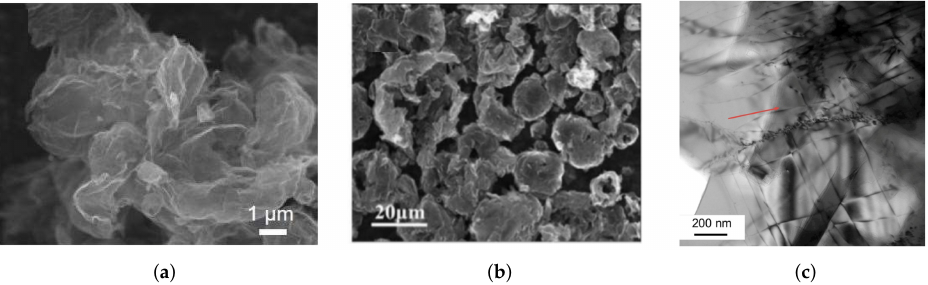
Figure 1. ( a ) SEM images of crumpled and spherical rGO powders. Reprinted with permission from [21]. ( b ) SEM image of crumpled graphene balls. Reprinted with permission from [22]. ( c ) Bright-field image of Al/graphene composite. Reprinted with permission from